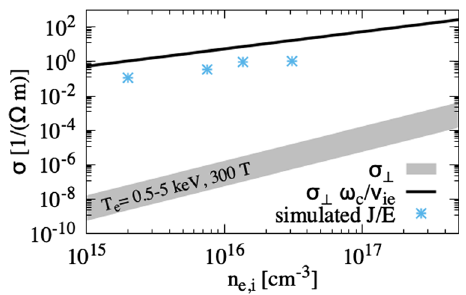
FIG. 16. The conductivity perpendicular to the B field as a function of n e . σ ⊥ is plotted for the range T e ¼ 0 . 5 – 5 keV with fixed B ¼ 300 T and n i ¼ n e (gray). Equation (10) is plotted for 300 T (black). Estimates of σ ⊥ ¼ J ⊥ = E ⊥ from the simulations in Fig. 14 are shown as